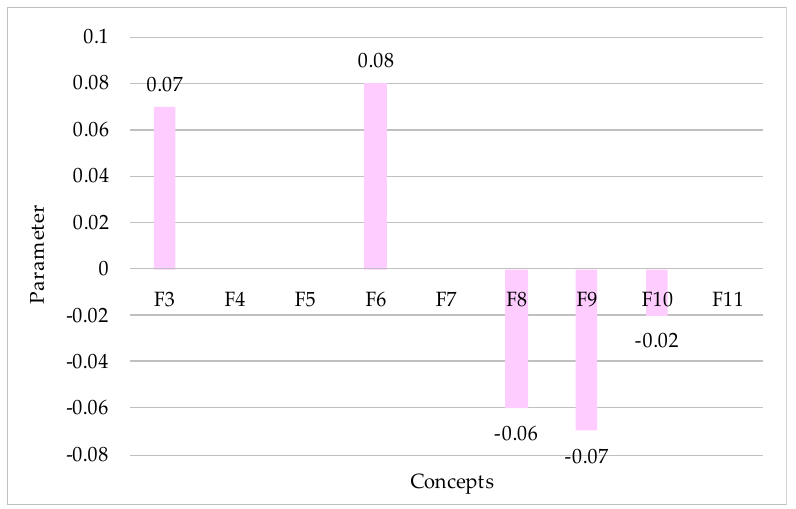
Figure 4. Scenario demonstrating the system response to the most negative changes in the concept 7F —malware.